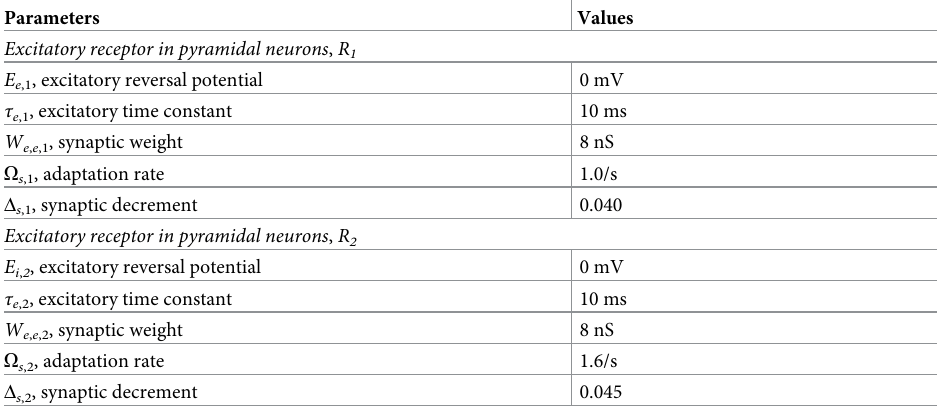
Table 3. Parameters used in a pyramidal neuron model with two excitatory